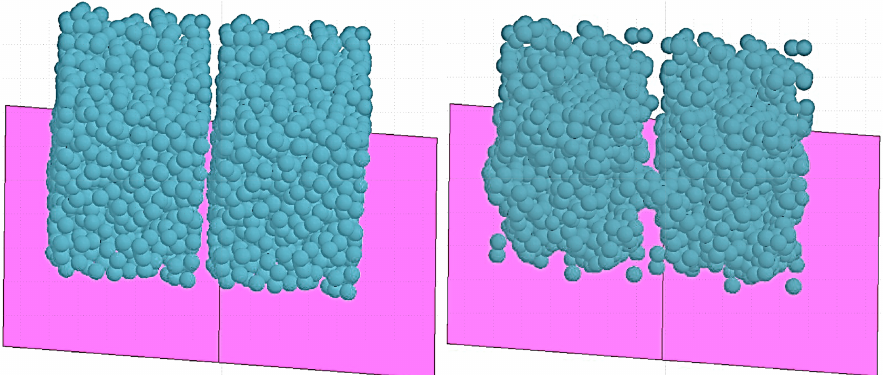
Figure 10. An example of the standard outcome of the simulations of the microstructure changes during debinding in zero gravity obtained using discrete element modelling of two rectangular cuboids: ( left ) before shrinkage and ( right ) after